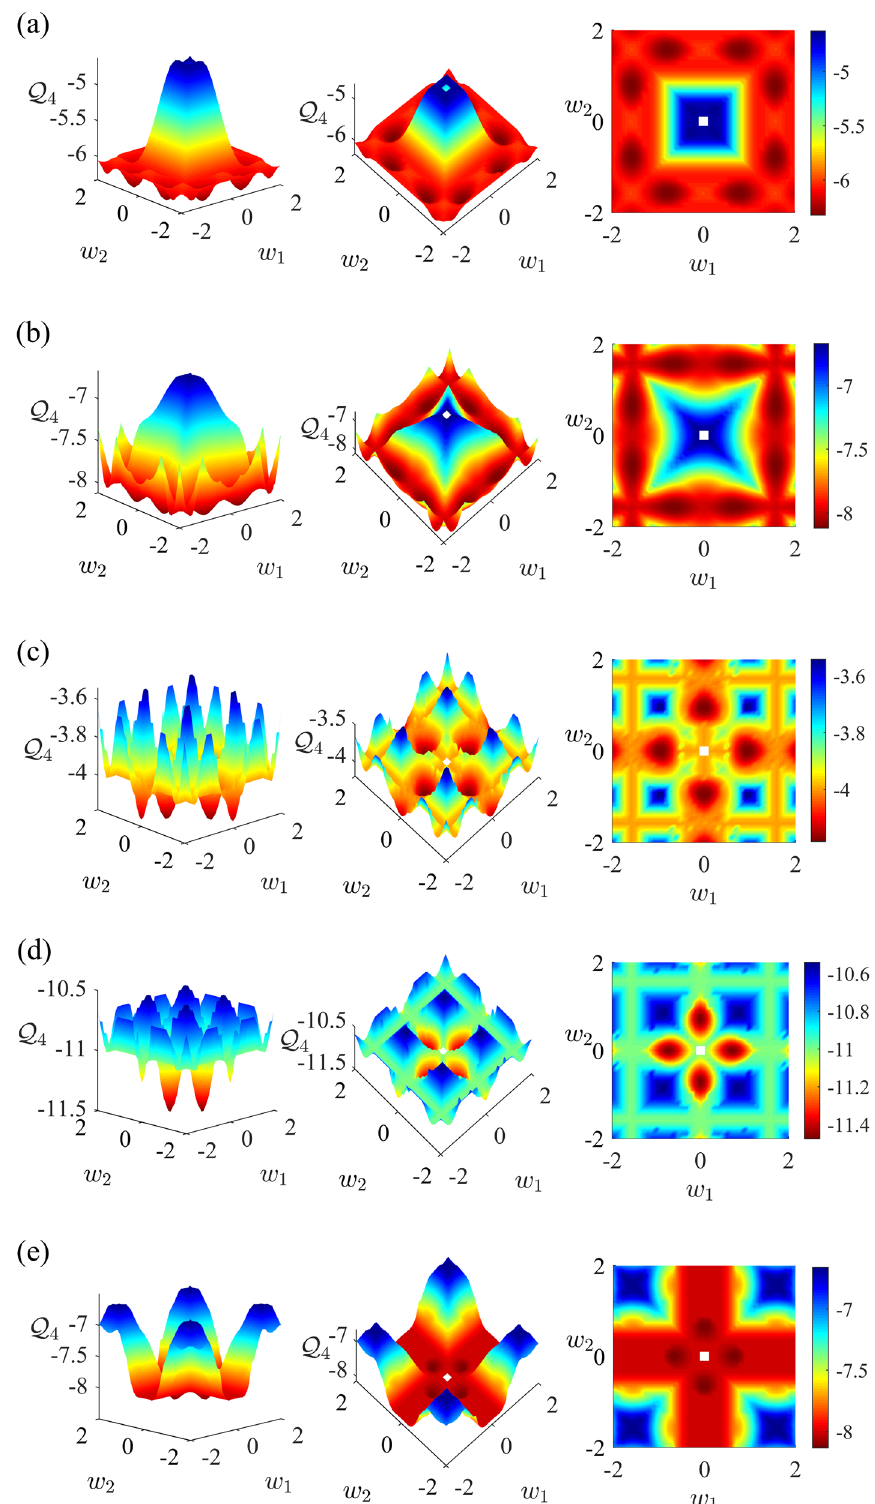
Fig. 6 Ground state energy surfaces for selected Hamiltonians with local dimension 4. Q 4 surfaces of fi ve models in Table 3 and Supplementary Table 2, where w 1 , w 2 both take discrete values on [ − 2, 2] at the interval 0.1. Three different viewing angles are shown for each model. The leftmost panel is a 3D overview, the middle panel is for better visualizing the internal structure, and the rightmost panel gives the top-down view . a No. 1 in Table 3, L ¼ (cid:3) 6 . b No. 5 in Table 3, L ¼ (cid:3) 8 . c No. 8 in Supplementary Table 2, L ¼ (cid:3) 4 . d No. 19 in Supplementary Table 2, L ¼ (cid:3) 11 . e No. 23 in Supplementary Table 2, L ¼ (cid:3) 8